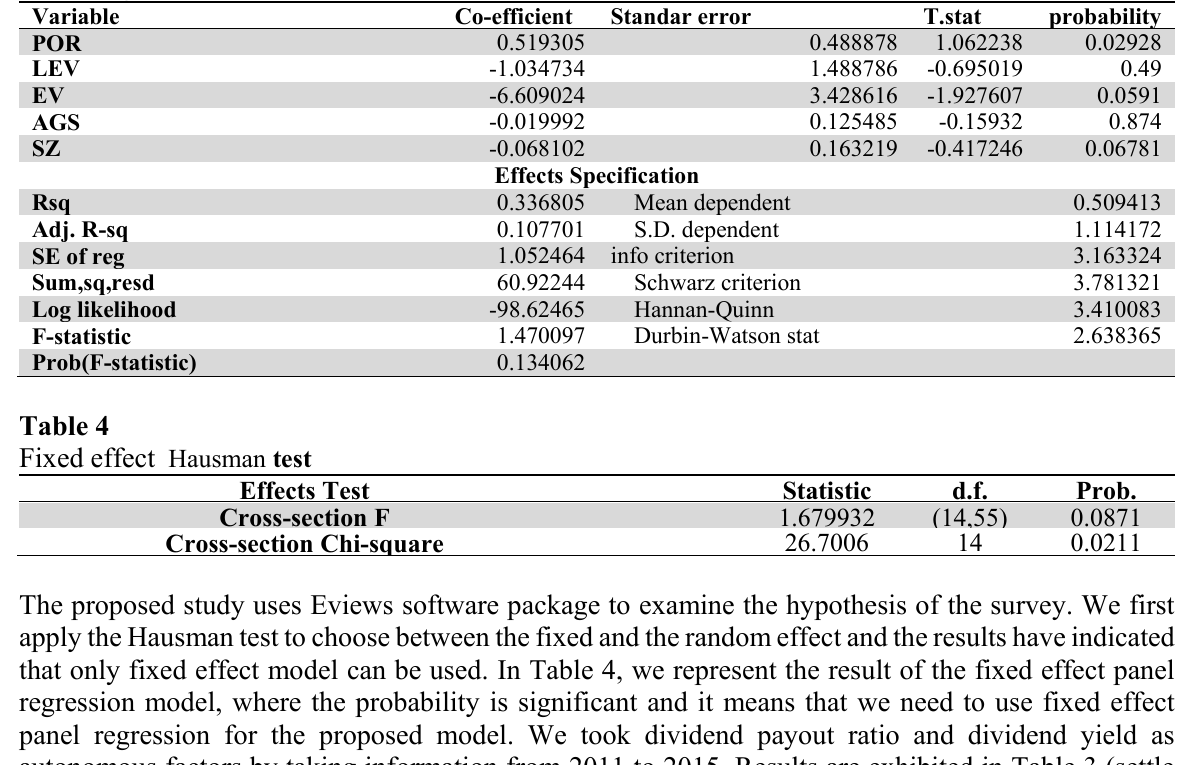
Panel Regression (Fixed Effect Model)